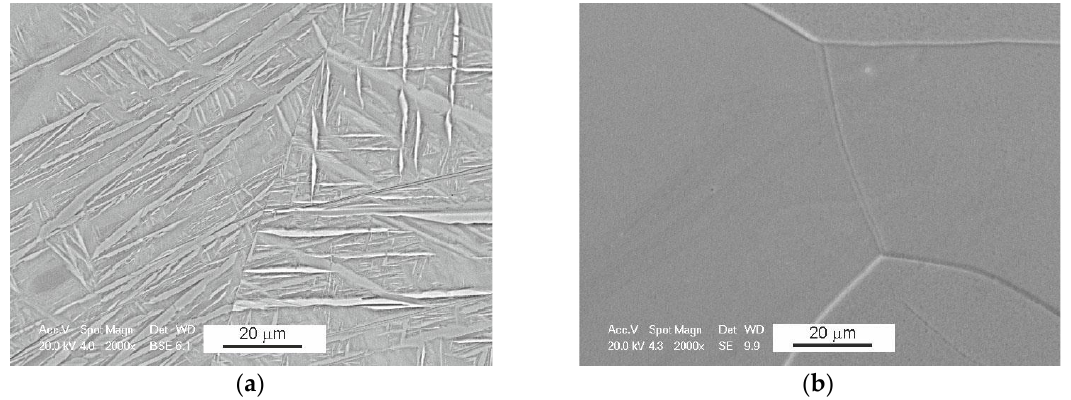
Figure 1. SEM micrographs of alloys annealed at 1000 °C for 24 h: ( a ) Ti – 1.5 wt.% Mo and ( b ) Ti – 15 wt.% Mo.